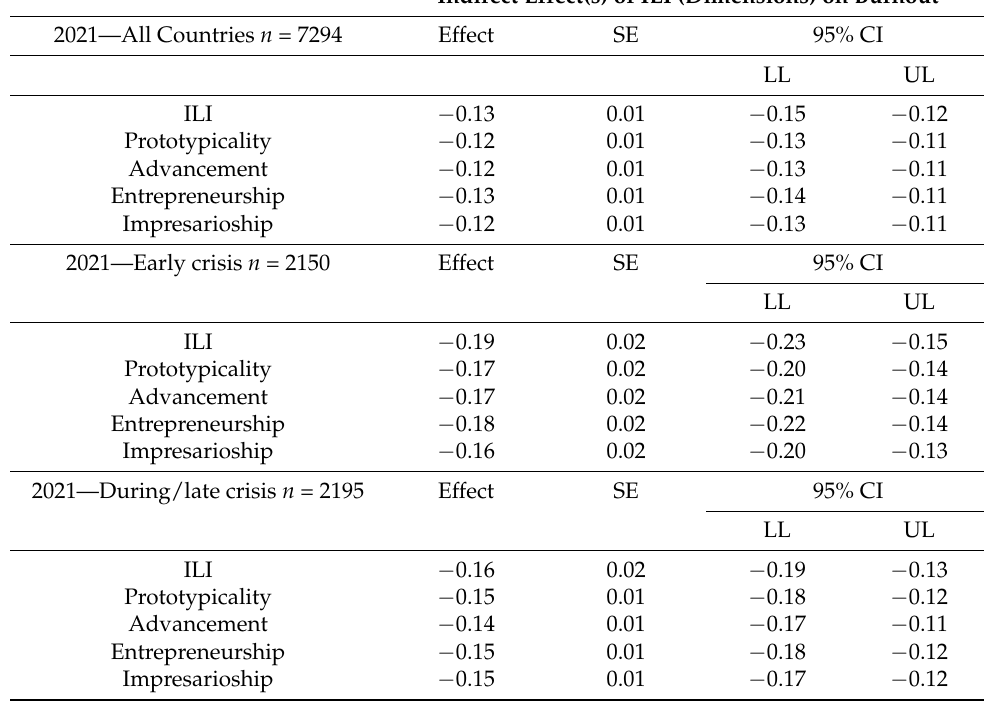
Table 5. Mediation: indirect effects on burnout via team identification for all countries and per